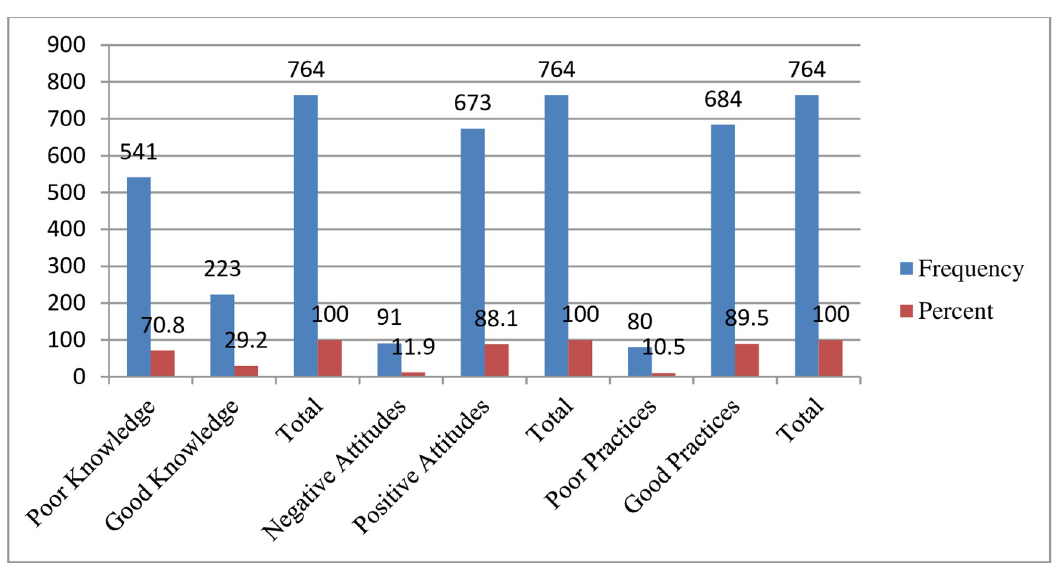
Fig 5. The overall face mask utilization and associated factors respondents on about knowledge, attitudes, and practices of face mask utilization and associated factors in COVID-19 pandemic among Wachemo university students, southern Ethiopia: February to March 2021 (n = 764).